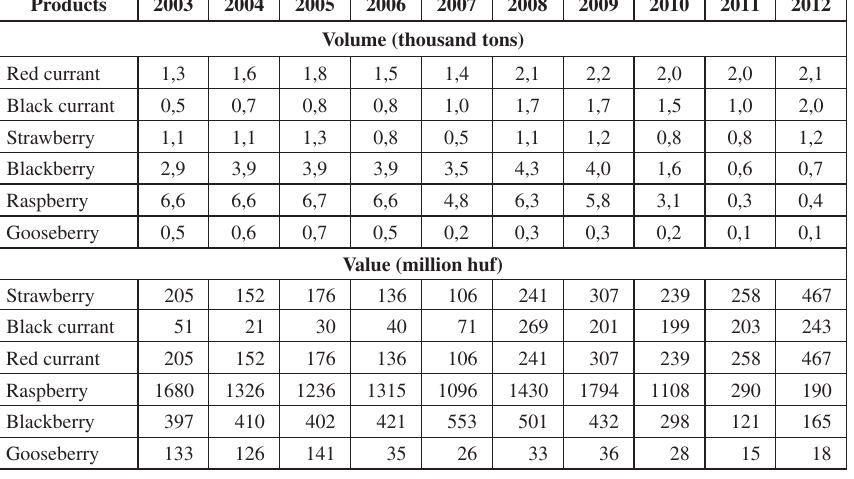
Table 1: Berries and nuts purchase of vegetable and fruit processing industry between 2003 and 2012